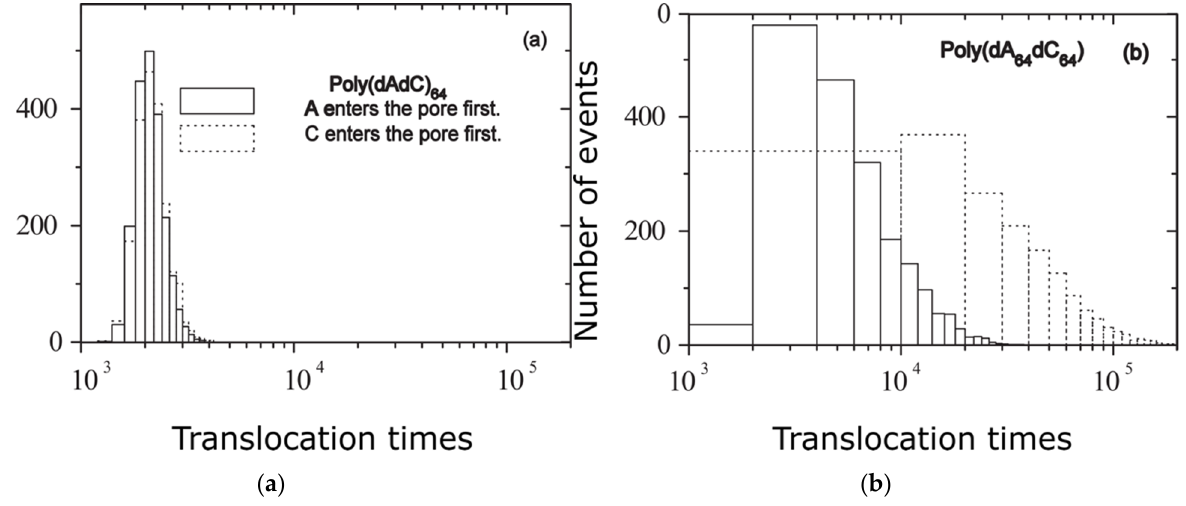
Figure 8. Translocation times histogram: ( a ) poly(dAdC) 64 and ( b ) poly(dA 64 dC 64 ) under F = 0.5. Nevertheless, for a lengthy/large block dimension, the histogram strays/diverges noticeably from a Gaussian repartition having an oblong exponential queue, as can be easily seen in Figure 8b.